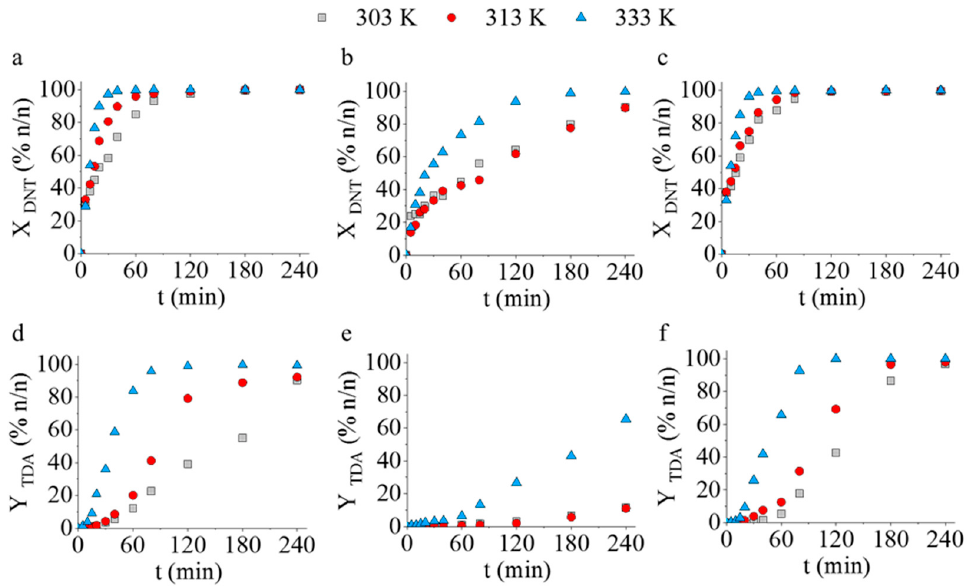
Figure 6. DNT conversions and TDA yields vs. time of hydrogenation at 303 K, 313 K, and 333 K using Pd/CoFe 2 O 4 -NH 2 ( a , d ), Pd/CdFe 2 O 4 -NH 2 ( b , e ), and Pd/NiFe 2 O 4 -NH 2 ( c , f ) catalysts. GC-MS measurements revealed the presence of two semi-hydrogenated intermediates, namely 4-amino-2-nitrotoluene (4A2NT) and 2-amino-4-nitrotoluene (2A4NT), which were not transformed to 2,4-TDA in the case of the Pd/CdFe 2 O 4 catalyst. By using the cobalt- or nickel-based catalysts (Pd/CoFe 2 O 4 -NH 2 and Pd/NiFe 2 O 4 -NH 2 ) the two semi-hydrogenated compounds were completely transformed to 2,4-TDA after 120 min hydrogenation at 333 K, resulting a >99 n / n % selectivity (2,4-TDA) for both catalysts (Figure 7). In contrast, the selectivity was only 65% for the cadmium ferrite-supported catalyst. Byproducts were not detectable after the tests.